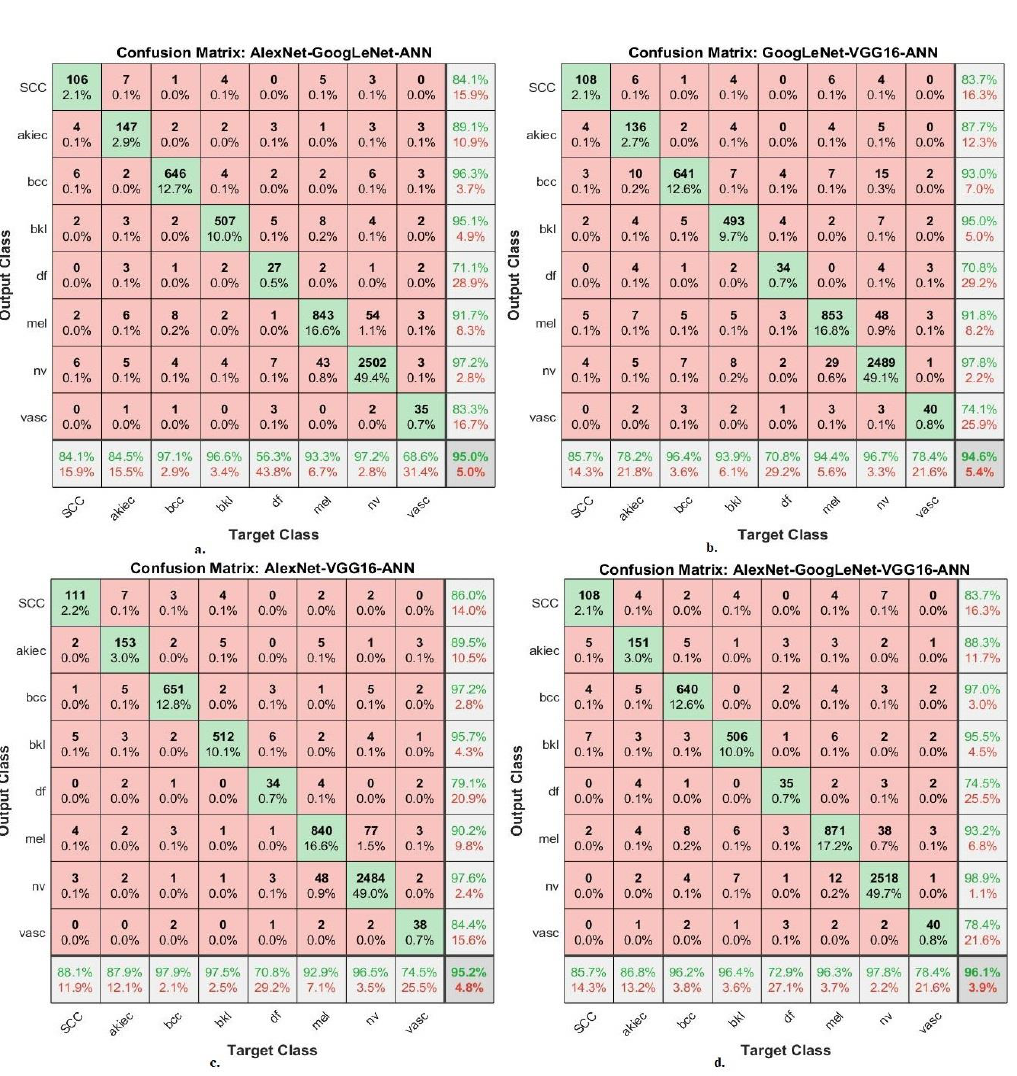
Figure 15. Confusion matrix for displaying performance results of CNN-ANN hybrid models based on the fused CNN models for early diagnosis and discrimination of skin cancer and other skin lesions ( a ) AlexNet-GoogLeNet-ANN ( b ) GoogLeNet-VGG16-ANN ( c ) AlexNet-VGG16-ANN ( d ) AlexNet-GoogLeNet-VGG16-ANN.